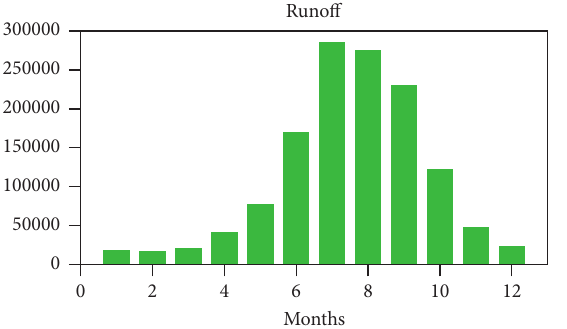
Figure 2: Monthly variation in the runoff at the Zhimenda station (units: × 10 4 m 3